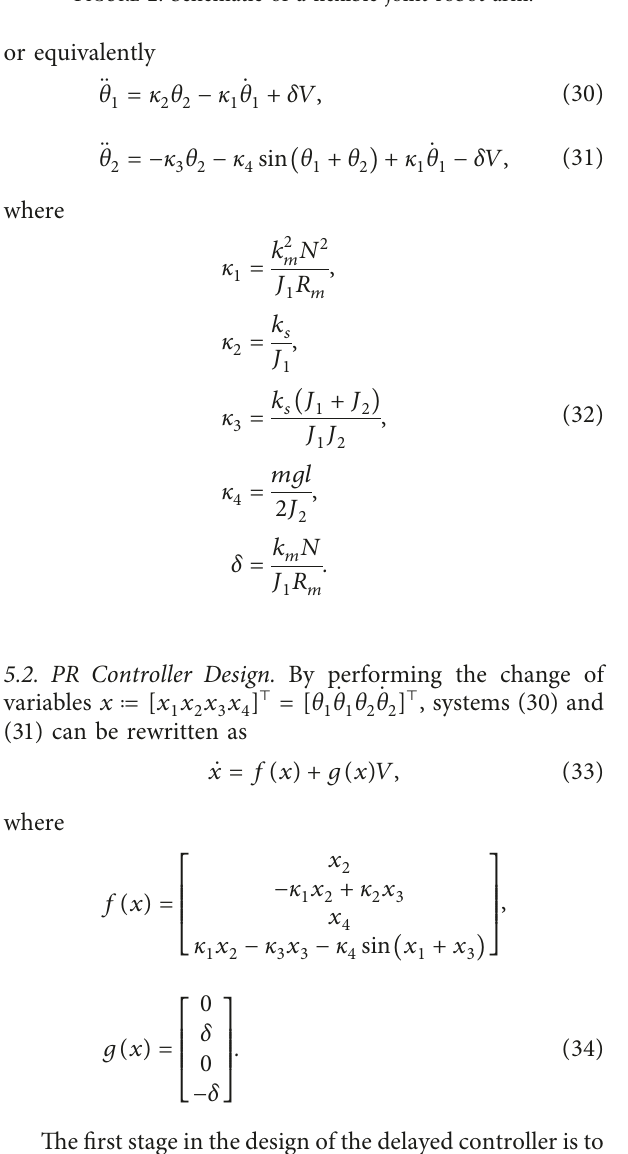
Figure 2: Schematic of a flexible joint robot